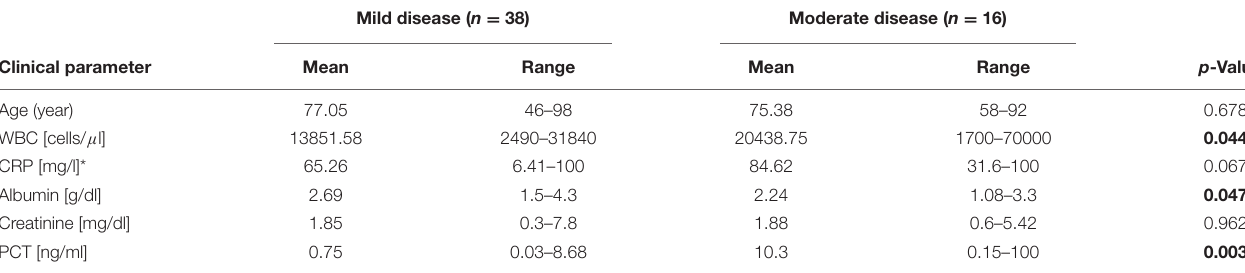
TABLE 2 | Clinical and laboratory parameters of CDI patients divided to mild and moderate severity disease groups.